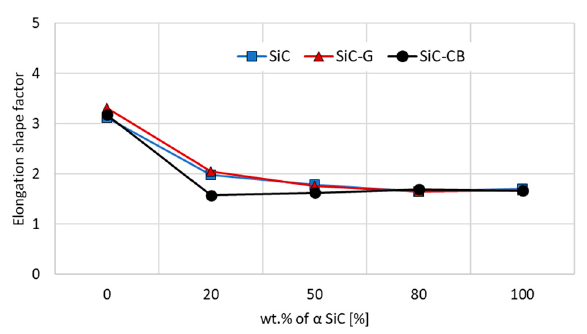
Figure 7. Grain elongation shape factor of SiC sinters.